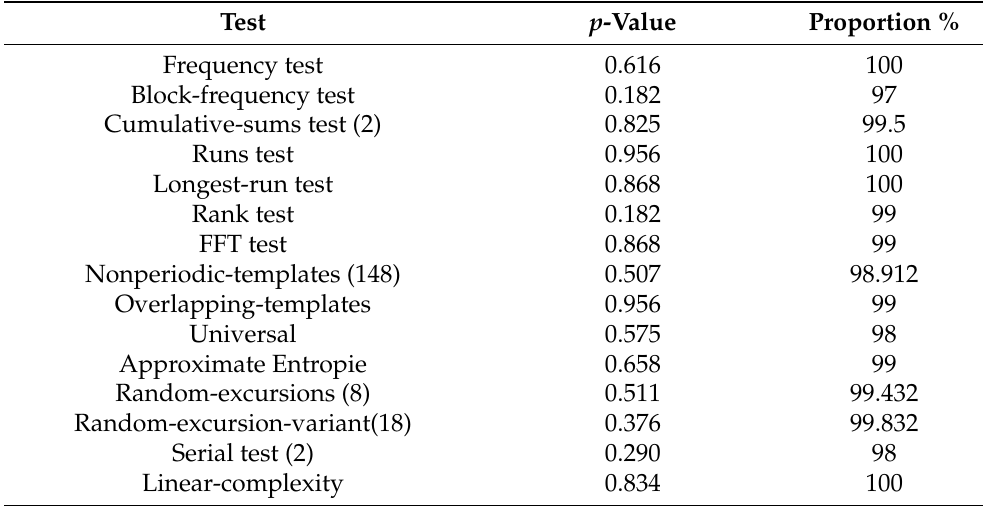
Table 3. P -values and proportion results of NIST